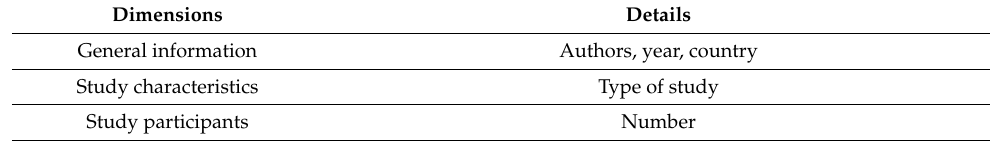
Table 2. Data extraction